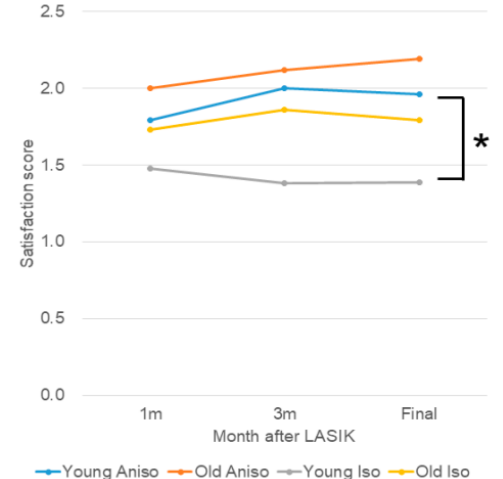
Figure 3. Satisfaction score stratified by anisometropia. The final satisfaction scores of the younger anisometropic group was poorer than the score of the younger isometropic group ( * p = 0.002), whereas there was no di ff erence between the older groups. Blue, younger anisotropic group; red, older anisometropic group; grey, younger isometropic group; yellow, older isometropic